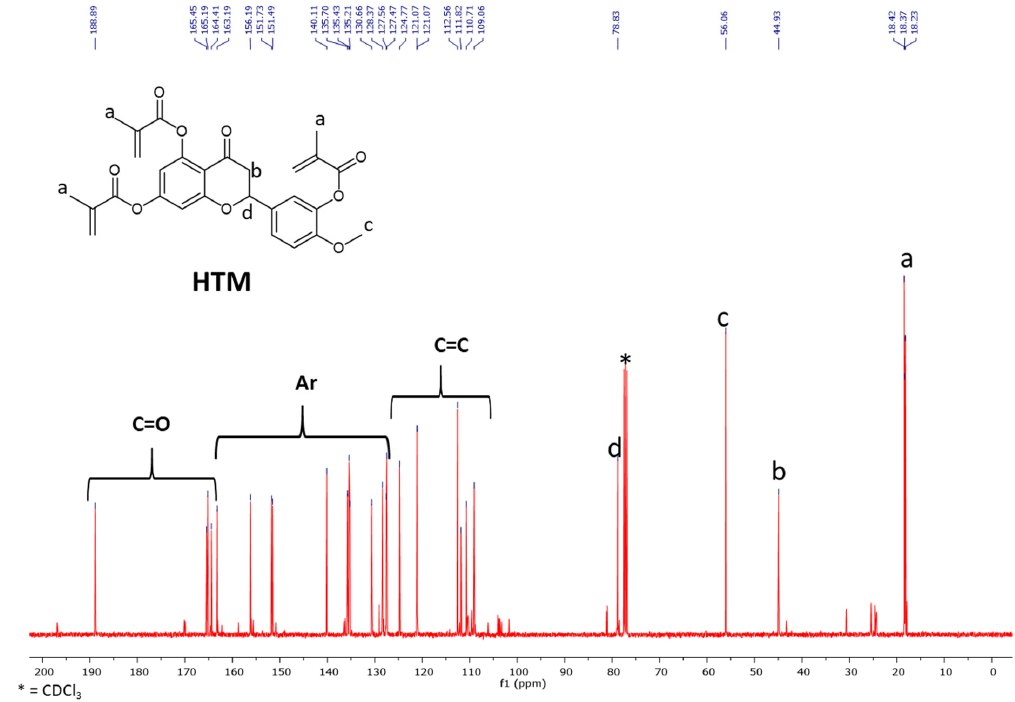
Figure 2. 13 C NMR spectroscopy spectrum of HTM. FTIR-ATR spectrum of HTM is displayed in Figure 3. The identifiable methacrylate peaks are noticed in the HTM FT-ATR spectrum such as the ester C=O functionality near 1760 cm − 1 as well as the keynote peaks of the methacrylate double bond (C=C) at 943 cm − 1 .